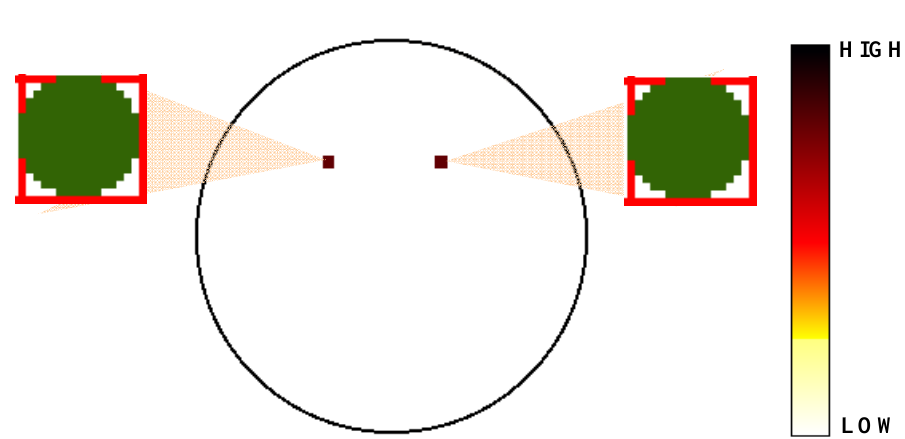
Figure 7. Tomogram results for two objects flow model. TWO OBJECTS FLOW MODEL